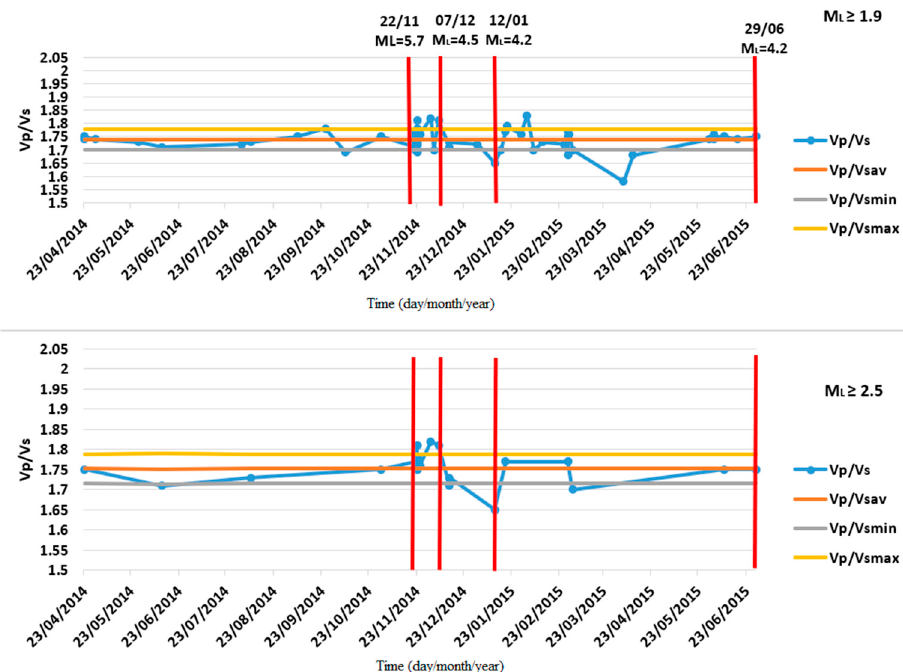
Figure 11. Vp/Vs temporal variation, as determined by the analysis of earthquakes that occurred in the Focsani Basin and surrounding areas during the specified time period (1 April 2014–30 June 2015), with M L ≥ 1.9 ( top ) and ML ≥ 2.5 ( bottom ). Significant earthquakes produced during the spec- ified period are marked with red vertical